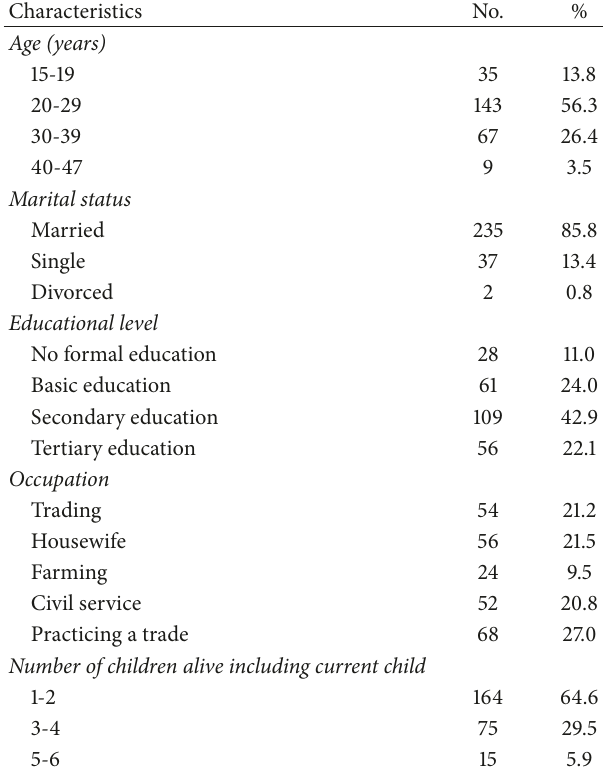
Table 1: Background characteristics of study